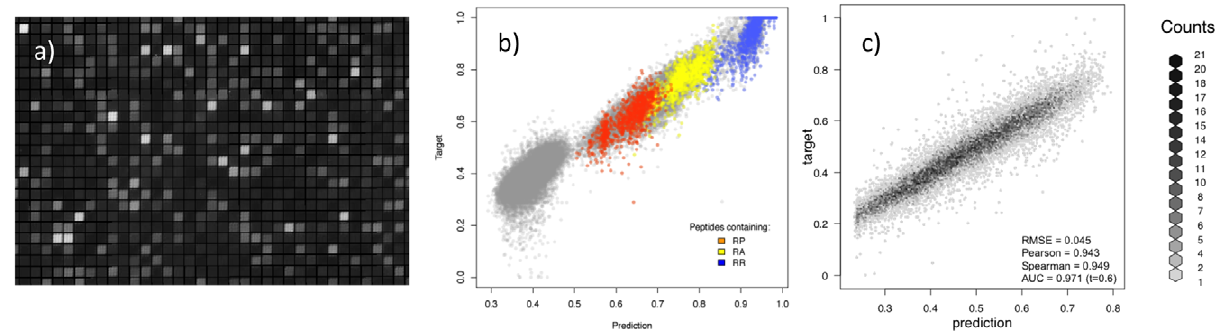
Figure 5. Analysing high-density peptide array data with NNAlign . a) Fluorescence microscopy picture of a peptide microarray. The image is a magnified segment of the peptide chip used in the trypsin cleavage analysis. b) Trypsin peptide-chip data. The normalized observed (target) likelihood of cleavage as a function of the prediction score for the trypsin data set. Localizations of peptides containing the pairs of amino acids RP, RA or RR are highlighted in the plot. Proline (P) is known to prevent cleavage after arginine (R), whereas cleavage is observed with other amino acids such as R and A. c) Chymotrypsin peptide-chip data. Correlation plot between predicted and measured (target) data from the chymotrypsin data set. Values are binned by their x,y proximity, so that the scatterplot represents the density of data in each bin. NNAlign was trained with linear rescaling of the quantitative data, a motif length of 4 amino acids without inclusion of PFR encoding, Blosum encoding of peptide sequences, a combination of 3,7,15 hidden neurons, 10 initial seeds, 5-fold exhaustive cross-validation, training was stopped on the best test set performance.